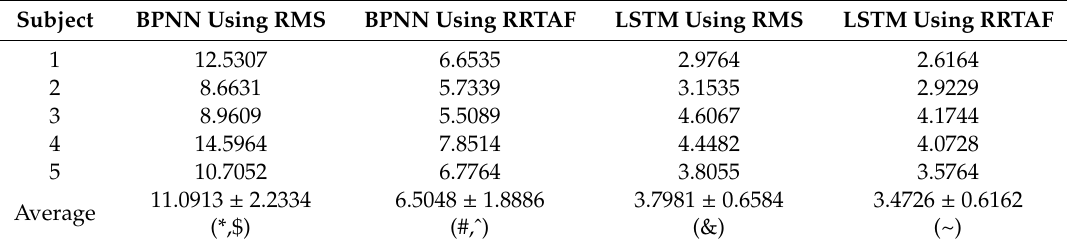
Table 3. RMSE obtained by the four methods for each